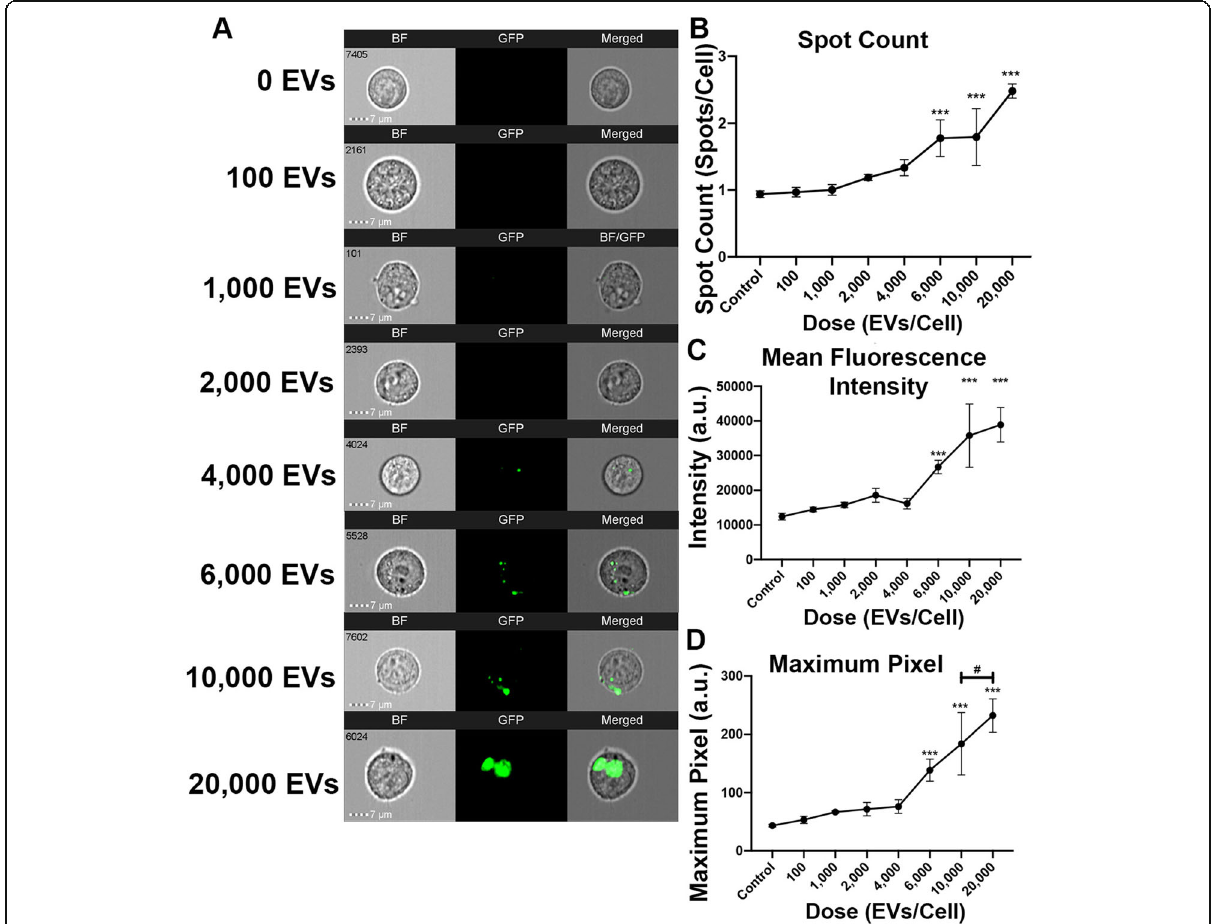
Fig. 3 HEK293T EV uptake has a dose effect with a minimum threshold of 6000 EVs. HEK293T cells were co-cultured with HEK293T EVS at increasing doses from 0 to 20,000/cell. a Representative IFC images of recipient cells with respective EV doses. GFP localization signifies HEK293T EV uptake. b – d Quantification of dose assays compared with controls and each group via spot count, mean fluorescence intensity, and maximum pixel ratios. Bars represent mean ± SEM; N = 3; one-way ANOVA followed with Tukey ’ s post hoc test. * p < 0.05; *** p <